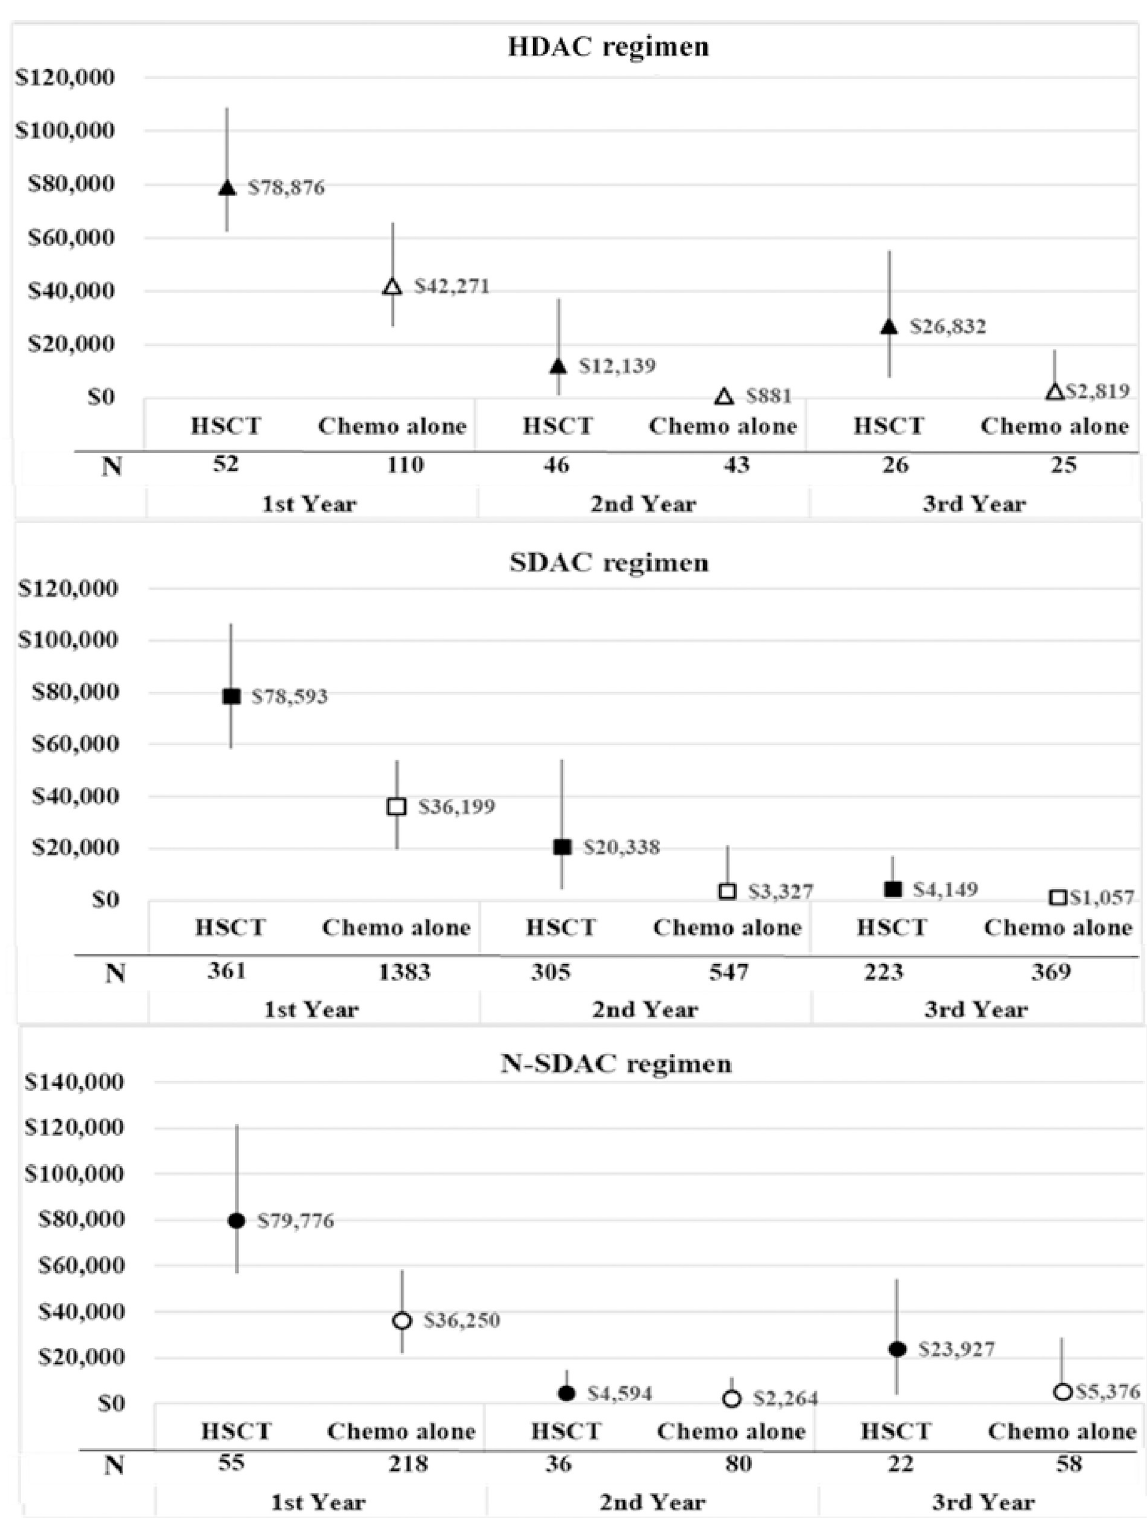
Fig 4. Median (IQRs) medical cost per patient in the 1 st , 2 nd and 3 rd year after AML diagnosis for patients who received chemotherapy alone or with HSCT, regimen stratify.